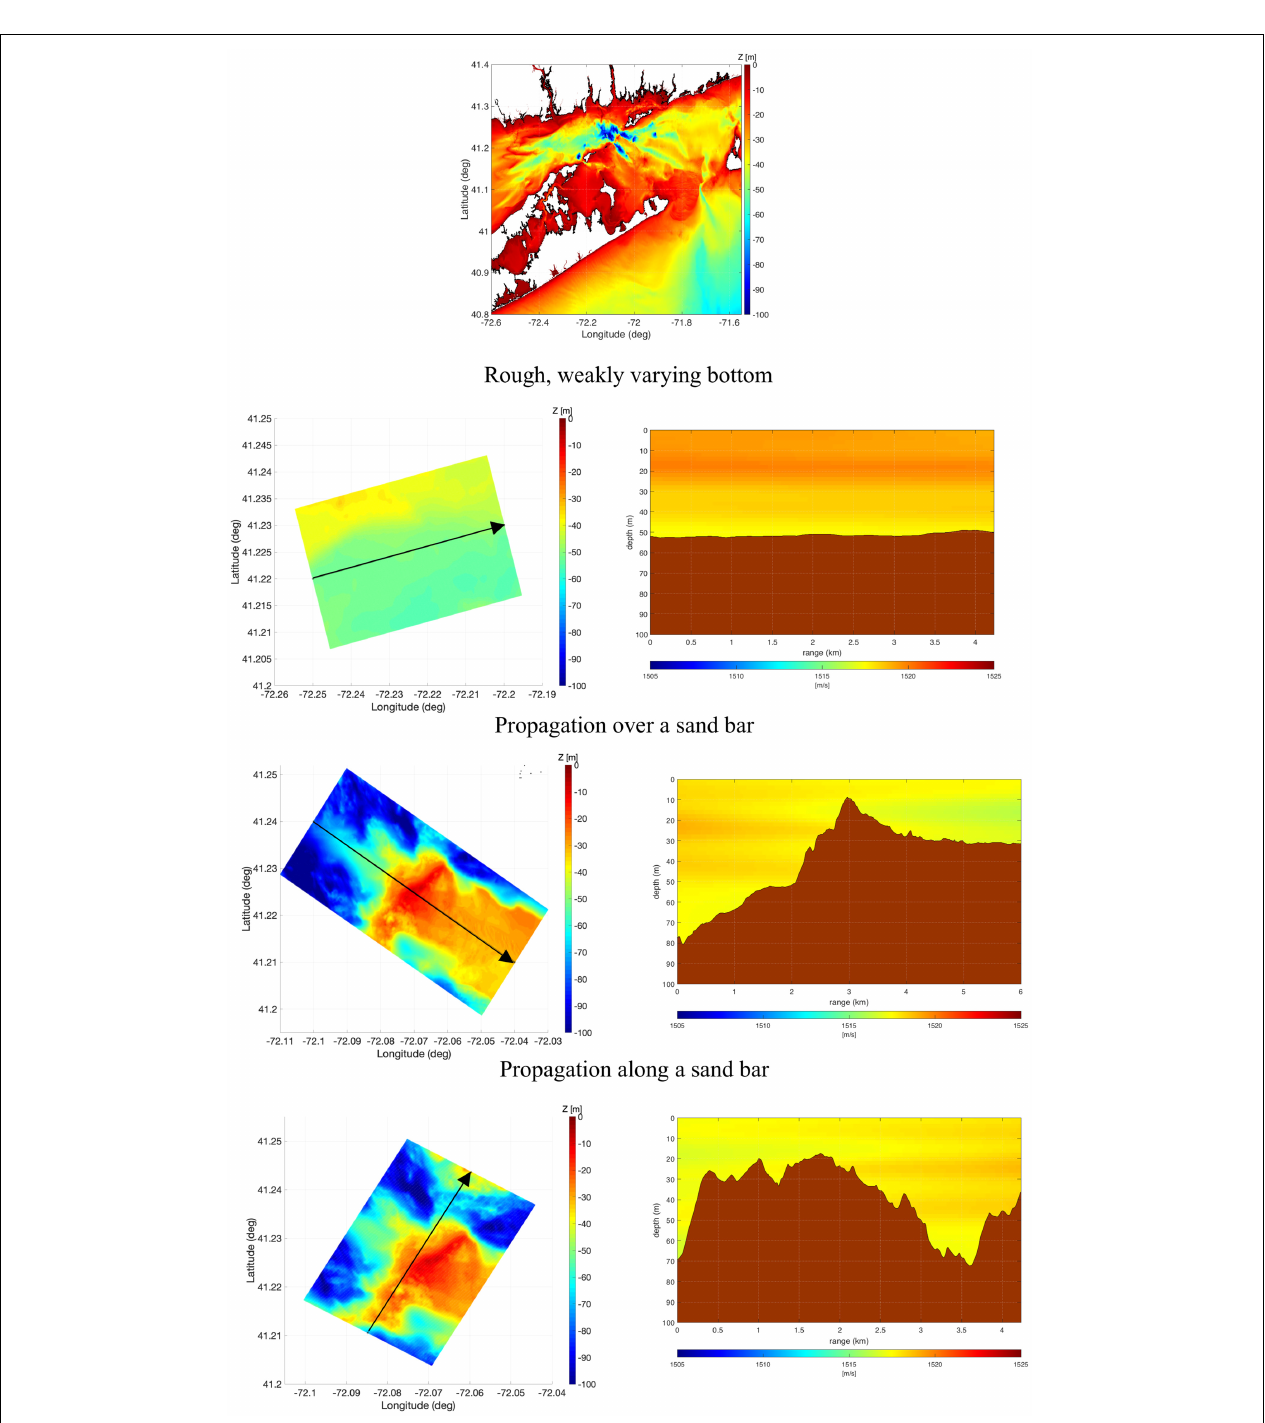
FIGURE 1 | Bathymetry of Long Island Sound (top panel) . Bathymetry and sound speed for the propagation scenarios: rough, weakly varying bottom flat bottom (second panel), propagation over a sand bar (third panel), and propagation along a sand bar (bottom panel) . Plots on the right present bathymetry and sound speed profiles along the central line of the propagation domains denoted by the arrow over the bathymetry map (plots on the left).